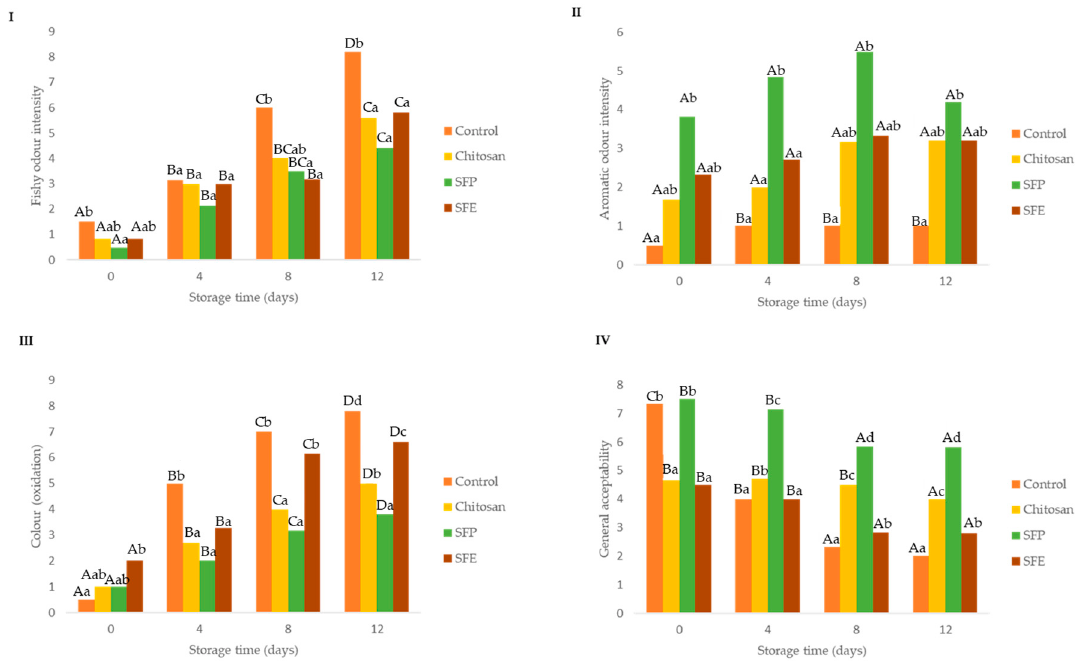
Figure 7. Effect of edible film sensory parameters: fishy odor intensity ( I ), aromatic odor intensity ( II ), color (oxidation) ( III ) and general acceptability ( IV ) in Atlantic horse mackerel burgers coated with different film formulations (control without coating film, chitosan, sea fennel plant (SFP) incorporated in a chitosan-based film and sea fennel extract (SFE) incorporated in a chitosan-based film) and stored at 4 °C for 12 days. Different uppercase letters indicate significant differences ( p < 0.05) over storage time in each treatment. Different lowercase letters indicate significant differences ( p < 0.05) due to the treatment.